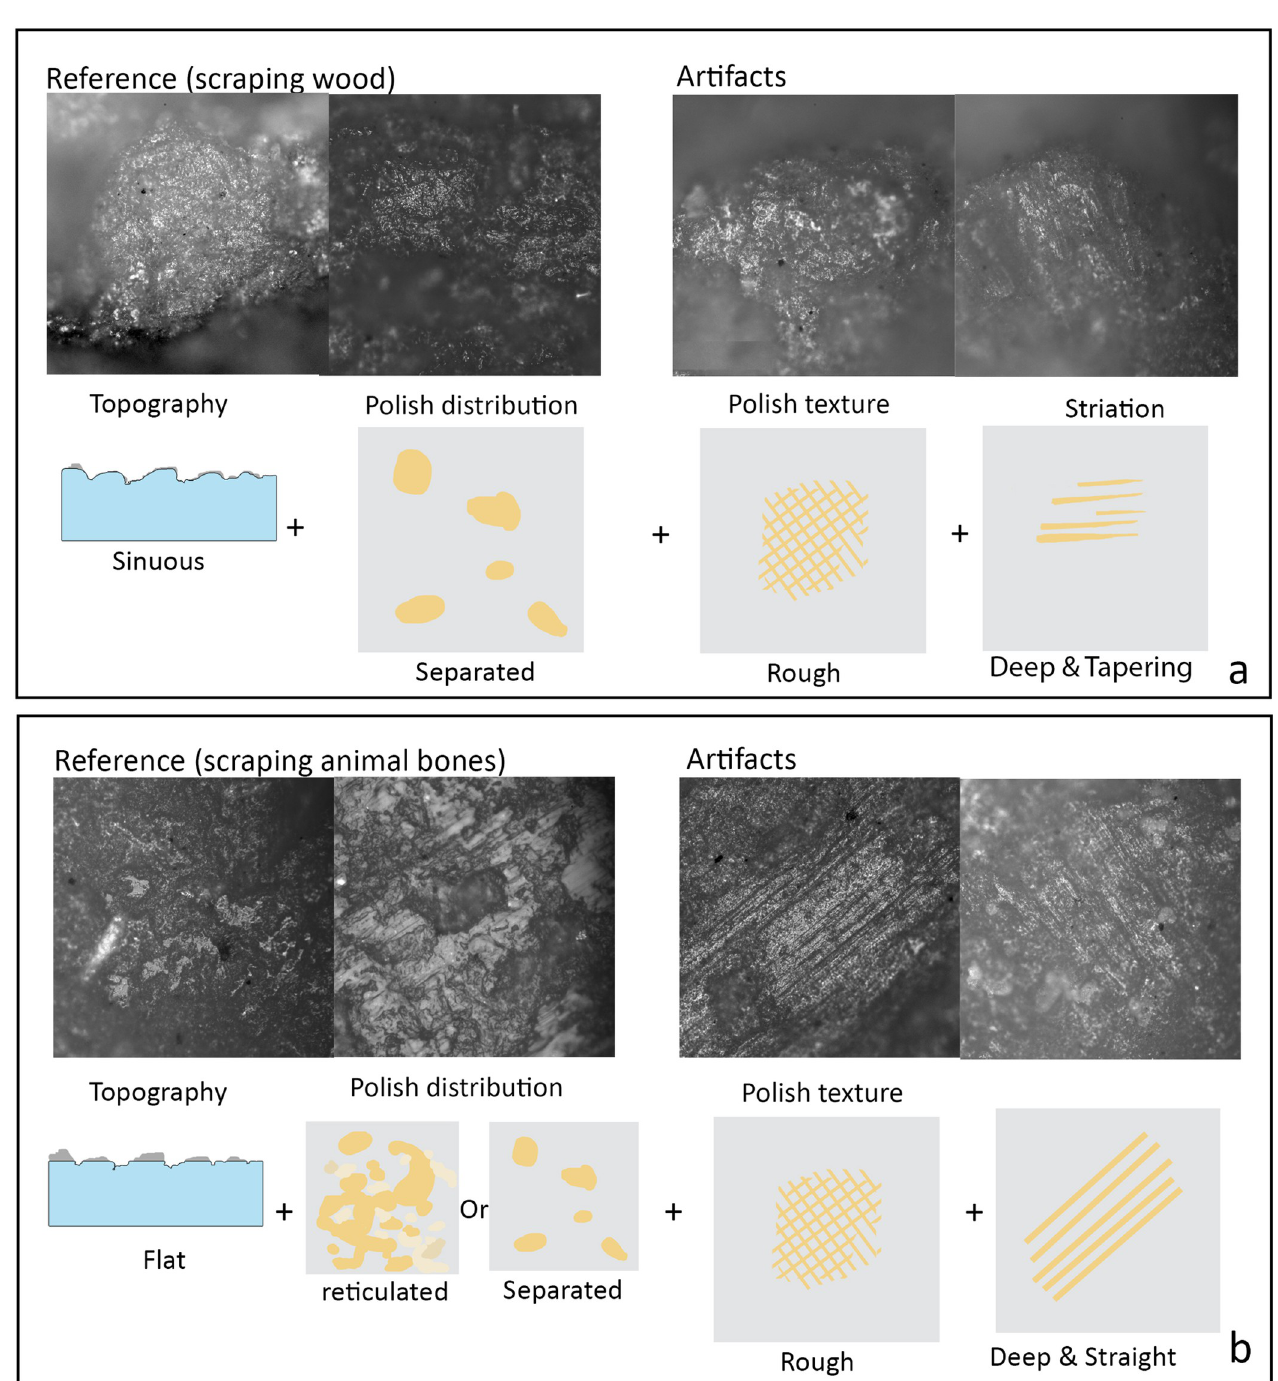
Fig 4. Use-wear traces from scraping wood (a) and scraping animal bones